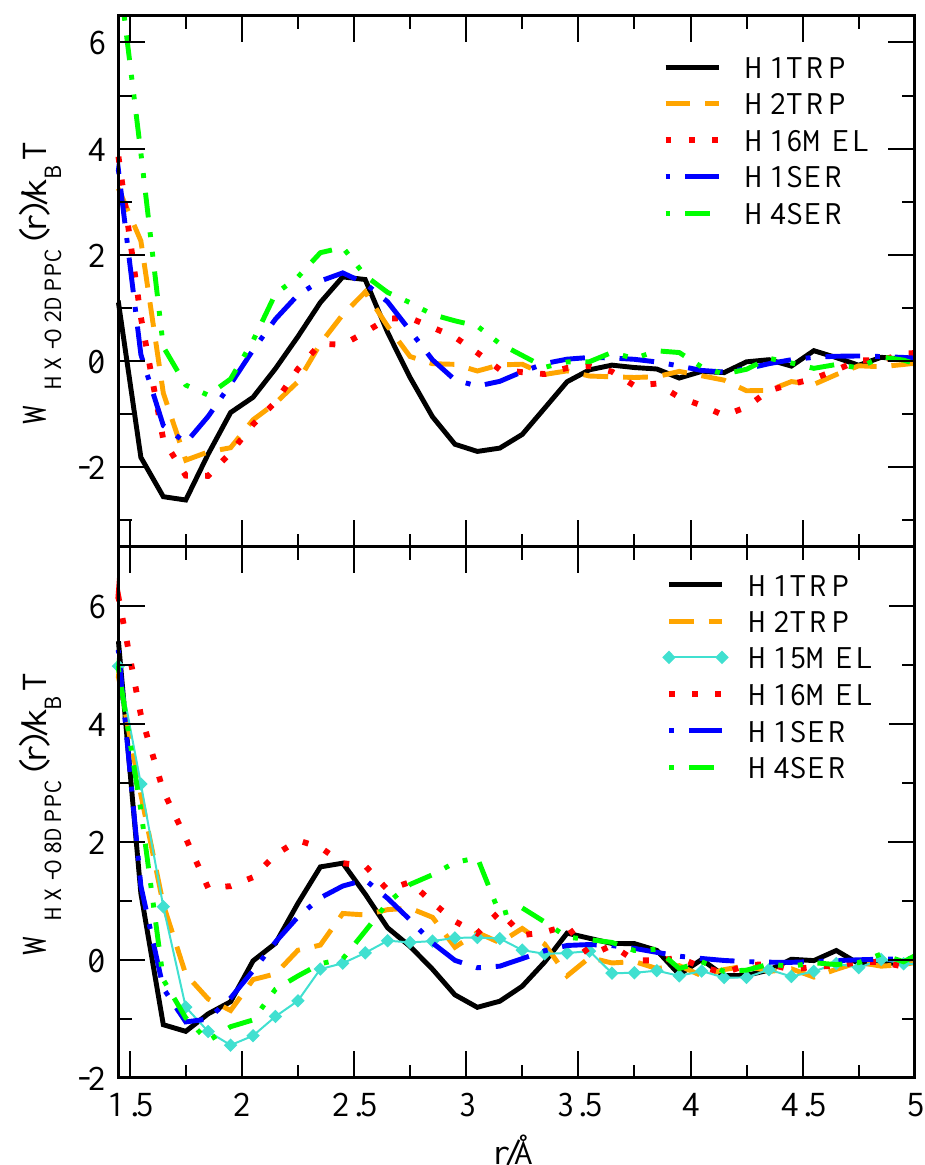
Figure 8. Reversible work W ( r ) (in k B T ) for DPPC-small molecules: TRP, SER and MEL. In the present system 1 k B T ∼ 2.7 kJ/mol. Hydrogen and oxygens of DPPC are indicated with same labels, as described in Figure 1. Data are partially taken from Ref.